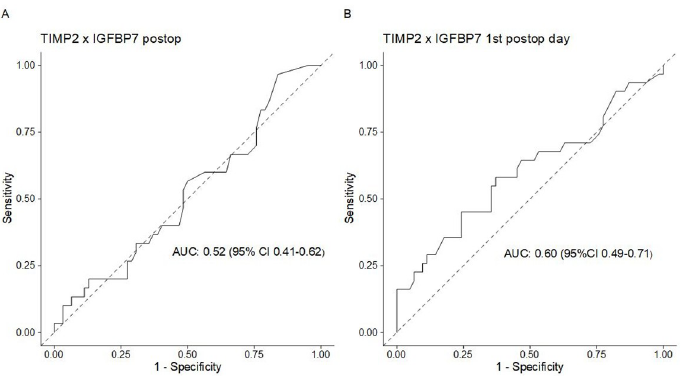
Fig 2. Receiver operating characteristic (ROC) curves of urinary (TIMP-2)x(IGFBP7). (A)post-operative (PO) and (B) first post-operative day (POD1) samples.